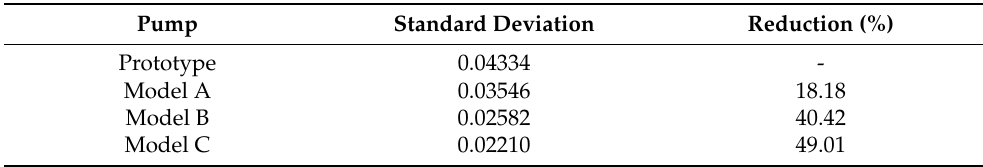
Table 2. Comparison of standard